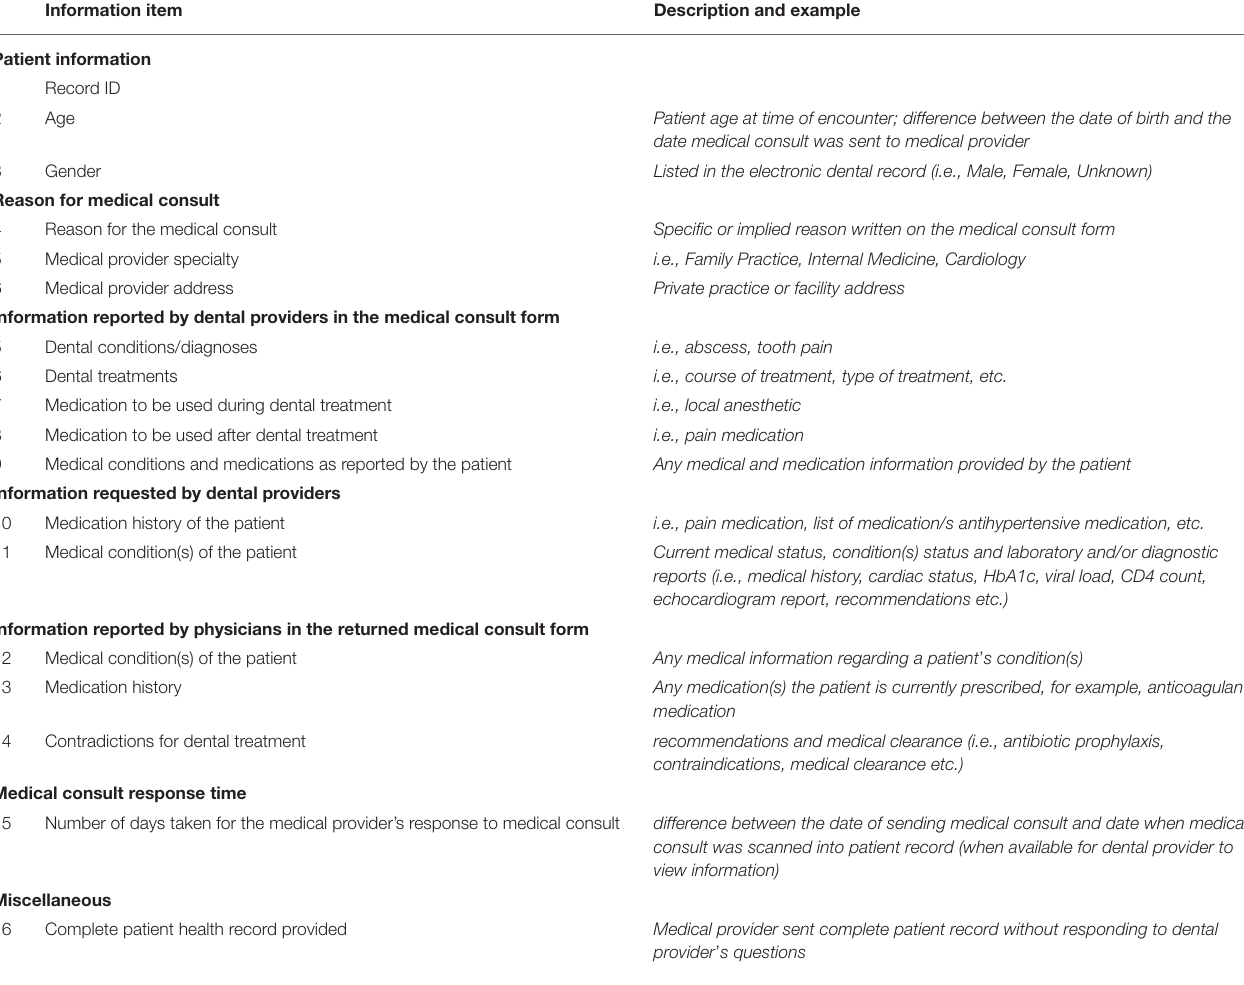
TABLE 1 | Data abstraction guidelines were developed and used to abstract information from the medical consult